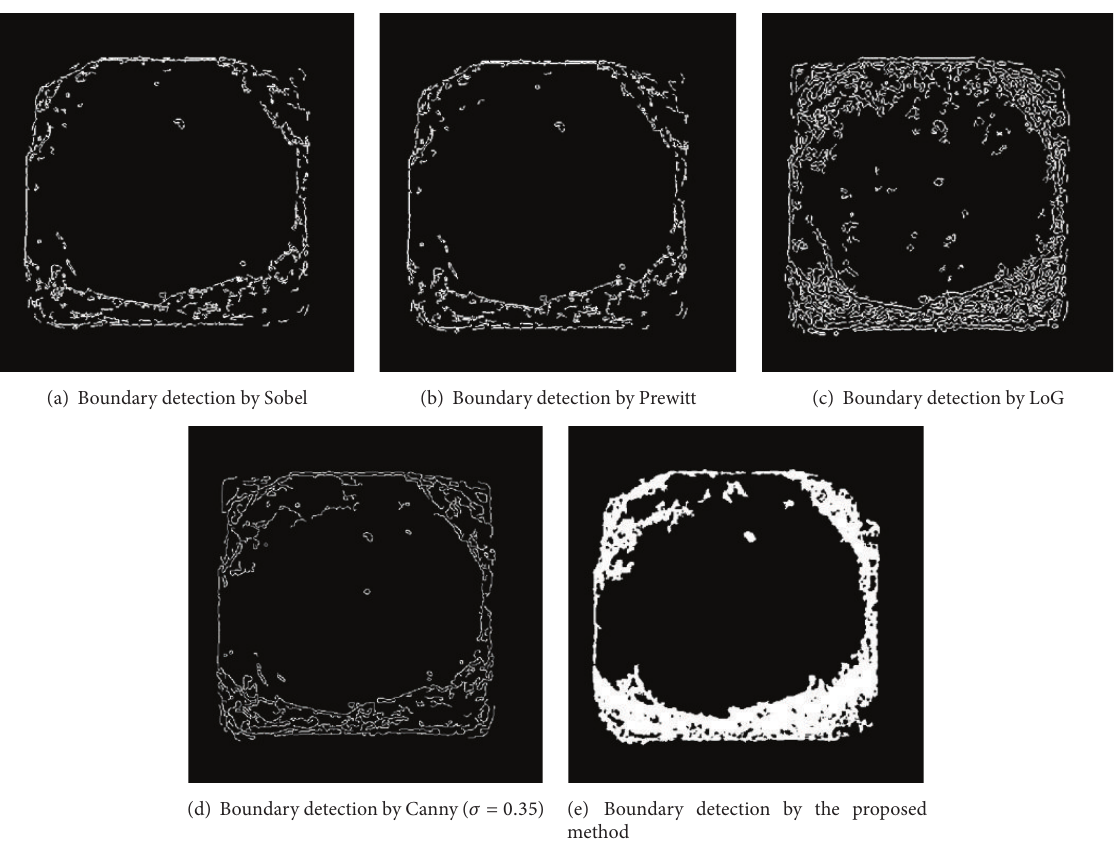
Figure 13: Comparison between conventional edge detection techniques and the proposed method for cube T1 (submerged for 180